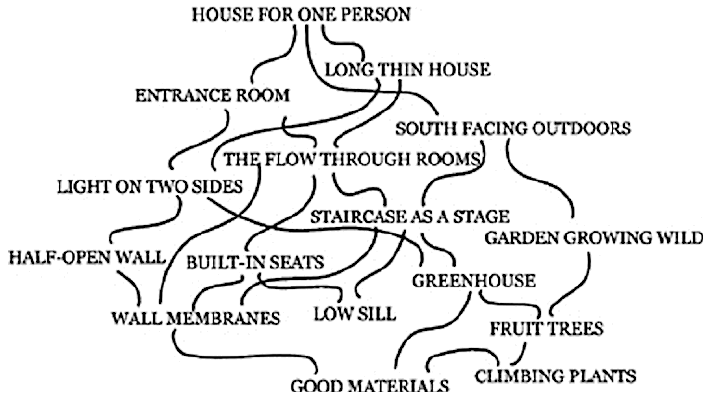
Figure 3. An illustration from Alexander’s The Timeless Way of Building [24], showing how the patterns within a language are connected through an overlapping web-network structure, similar to the one described in “A City Is Not a Tree” [5].